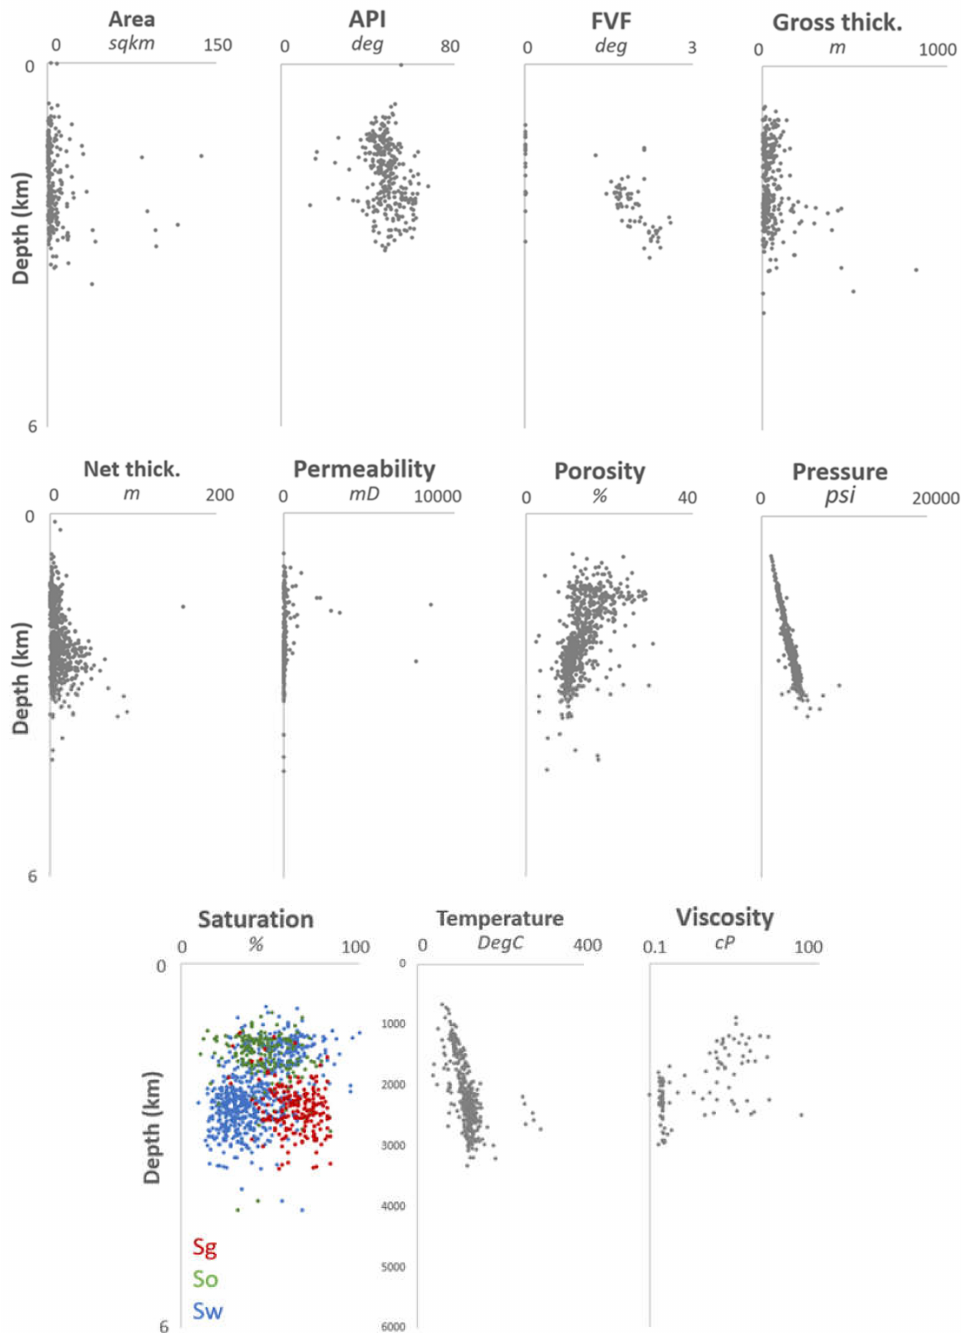
Figure 8. Cross-plots for various attributes against depth for Basin Y